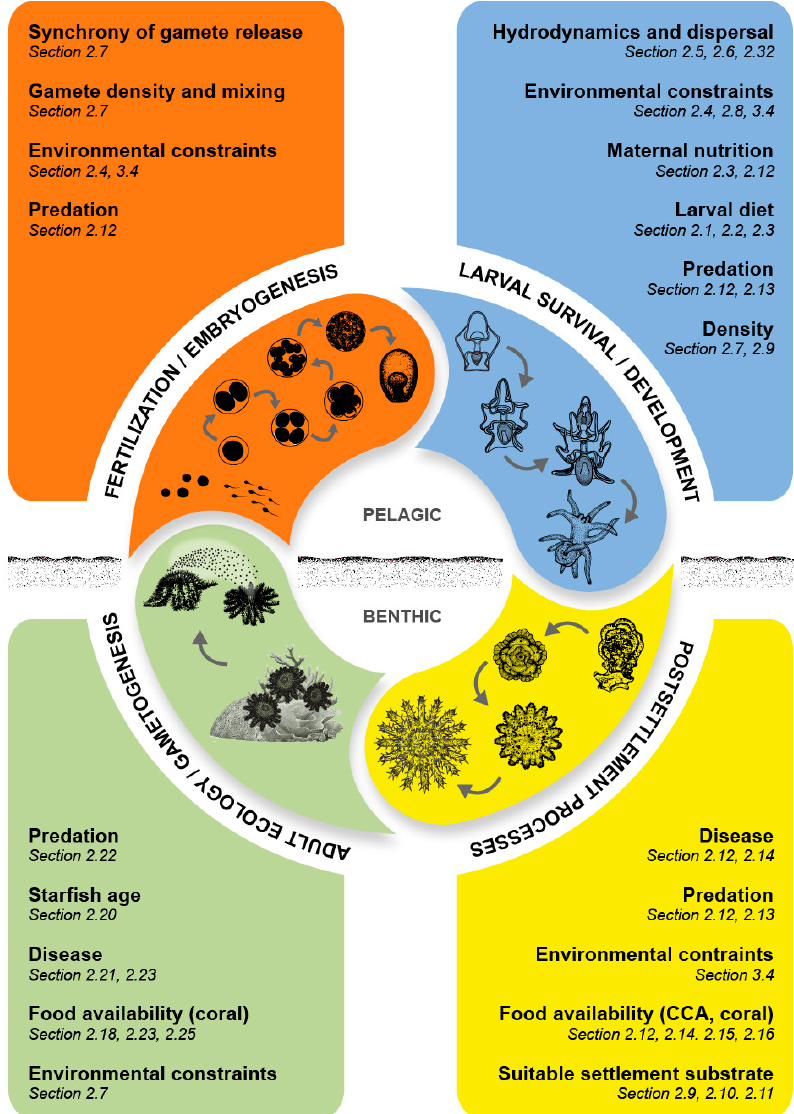
Figure 3. Generalized life cycle of Acanthaster spp. indicating potential sources of mortality and major bottlenecks in population replenishment, which are likely to be fundamental in understanding the occurrence of population outbreak. Late-stage larvae digitized from illustrations by M. Yamaguchi [61] and D. Engelhardt [134].